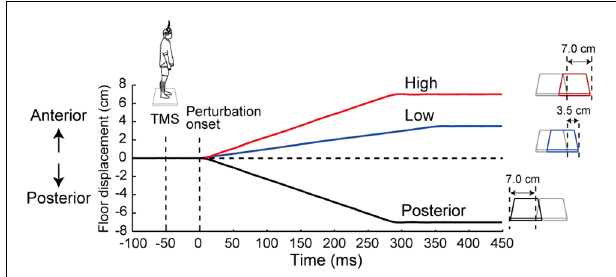
FIGURE 1 | The time course of the floor displacement of three perturbations and transcranial magnetic stimulation (TMS) in a single trial. Three waveforms show the floor displacement in the High, Low and Posterior conditions, i.e., the Anterior-large, Anterior-small, and Posterior-large perturbations, respectively. “0 ms” corresponds to the beginning of the floor movement. TMS was applied 50 ms before the start of each